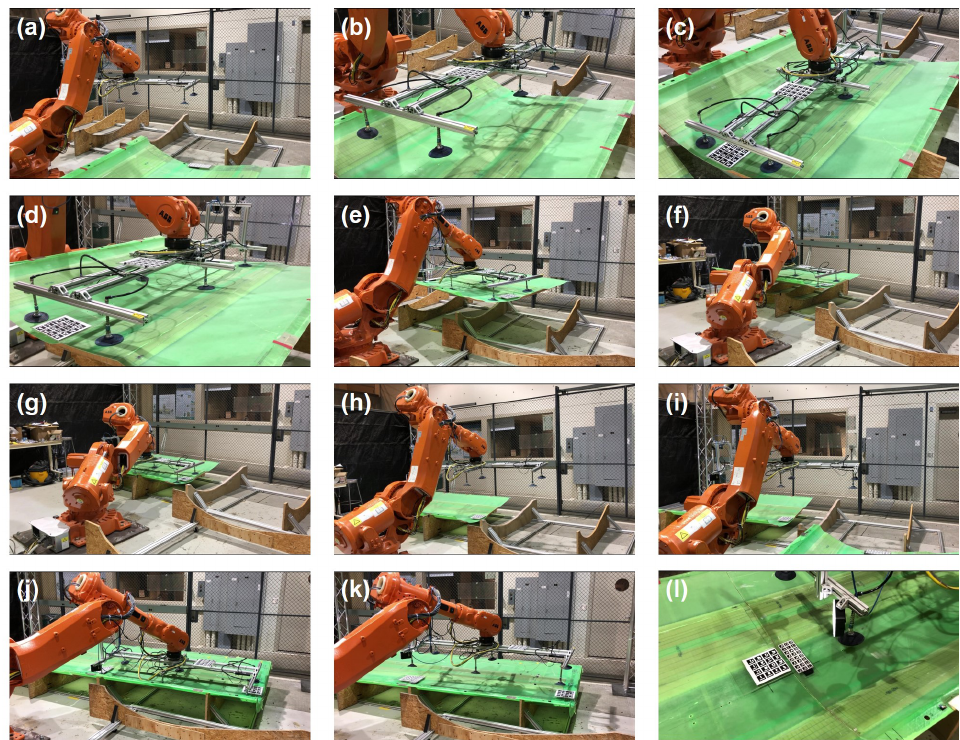
Figure 13. Snapshots of the assembly process: ( a ) Robot at initial pose and first panel ready for pickup in the pickup nest. ( b ) Panel pose estimated by overhead camera; robot moving to the pickup pose. ( c ) Robot approaching panel until all six suction cups well engaged. ( d ) Robot picking up panel. ( e , f ) Panel transported to above the first assembly nest. ( g ) Panel placed in the assembly nest based on vision and force guidance. ( h ) Robot returning to initial pose. ( i ) Second panel manually brought in and ready to be picked up. ( j ) Second panel picked up, transported, and placed in the second assembly nest following the same procedures as steps ( b – g ). ( k ) Robot releasing the panel. ( l ) Closer look at the seam between the placed panels. 1st Panel Placement Time Mean: 112.62, stdev: 18.8757